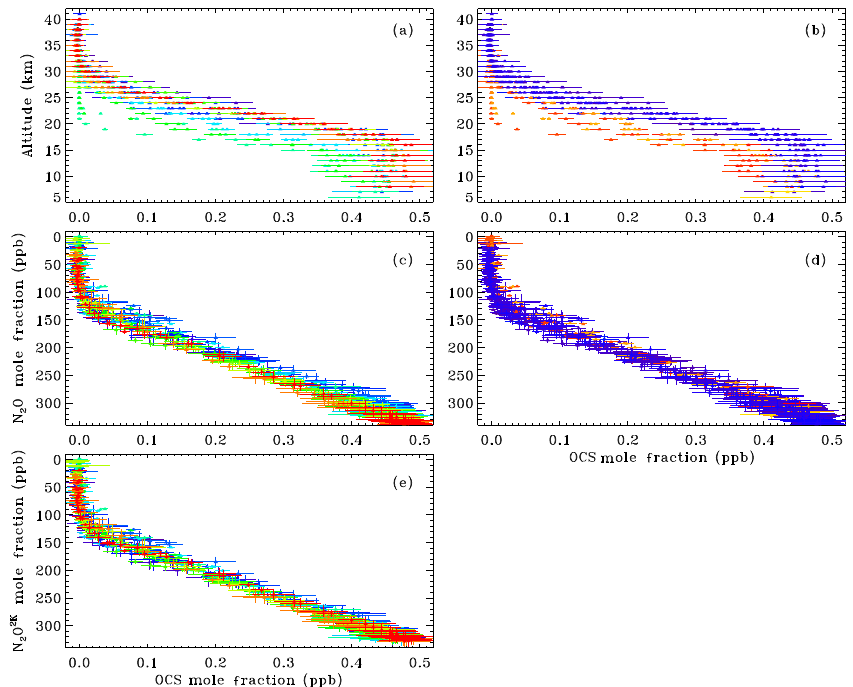
Figure 2. Profiles of OCS retrieved from MkIV balloon spectra by averaging results obtained from the five windows listed in Table 1. In the left-hand panels the points are color-coded by year (e.g., blue: 1990; green: 2000; red: 2014). In the right hand panels the same data are color-coded by latitude (blue: 35 ◦ N; red: 67 ◦ N). In the top panels (a, b) , the OCS is plotted versus altitude. In the middle panels (c, d) , the OCS is plotted versus N 2 O. In the bottom panel (e) the N 2 O has been de-trended by 0.25%yr − 1 such that it represents the year 2000 (N 2 O 2K ) . Only data with OCS uncertainties <50ppt and N 2 O uncertainties < 20ppb were plotted, which reduced the total number of points in each panel from 756 to